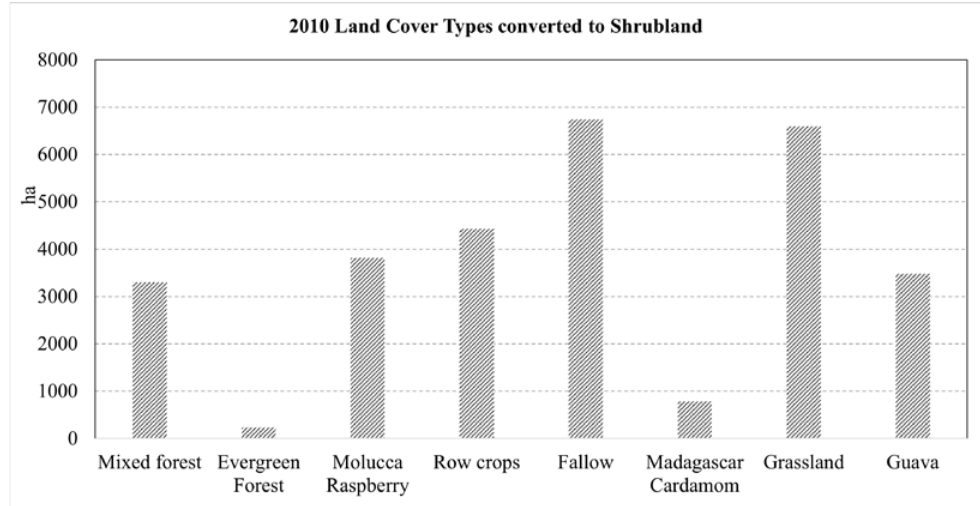
Figure 12. Percentage of classes in 2010 that were converted to Shrubland in 2019, within the study area based on the classification map extent seen in Figure 9. This information is useful for awareness-raising and conservation efforts.